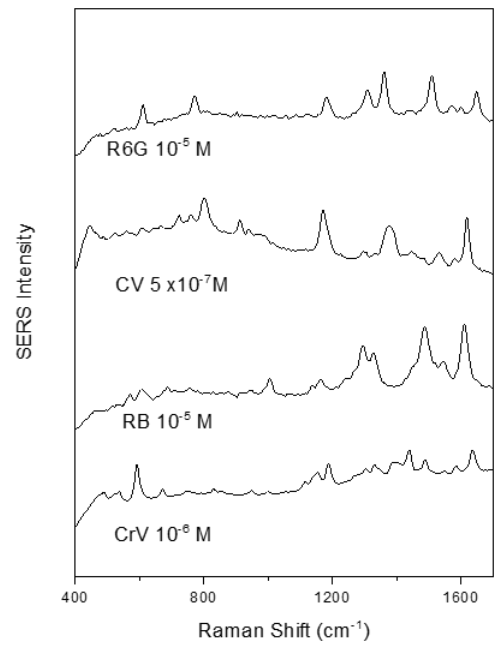
Figure 4. SERS spectra of rhodamine 6 G (R6G), crystal violet (CV), rose bengal (RB) and cresyl violet (CrV) having as substrate the